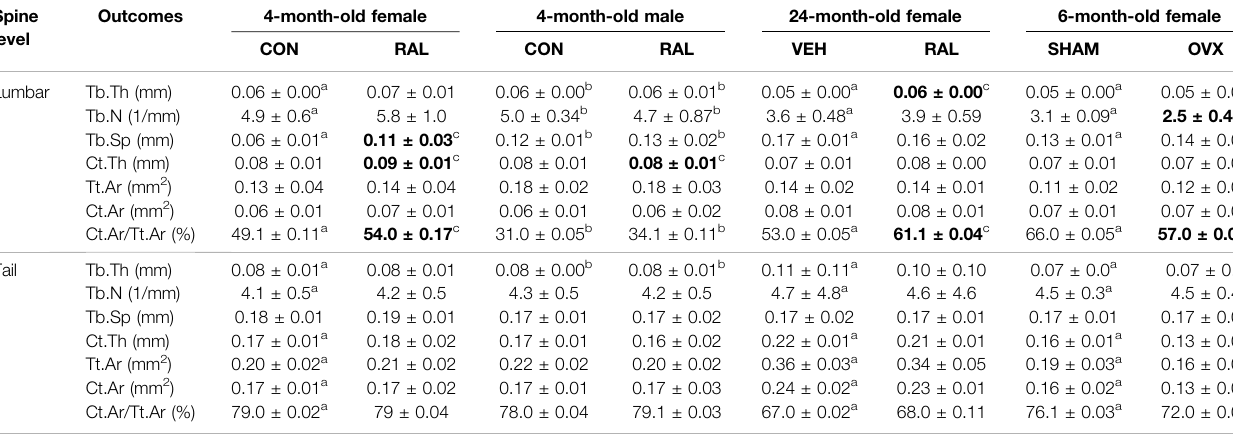
TABLE 3 | Raloxifene augmented lumbar trabecular and cortical bone structure. Spine Outcomes level